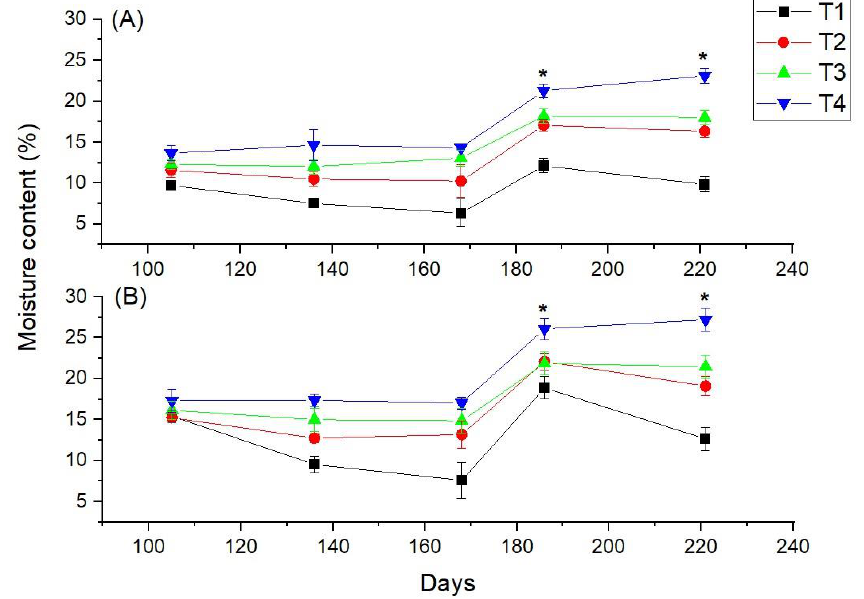
Figure 3. Effect of gypsum treatments on moisture conservation from 105 to 221 days of gypsum application at ( A ) 0 – 25 cm and ( B ) 25 – 50 cm soil depth. The symbol (*) represents the significant difference among the different treatments at the p value < 0.05.